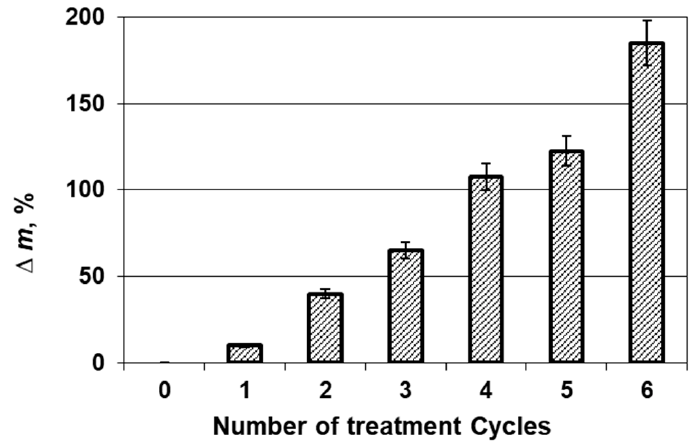
Figure 2. Influence of the treatment cycle number on the fibers mass change.